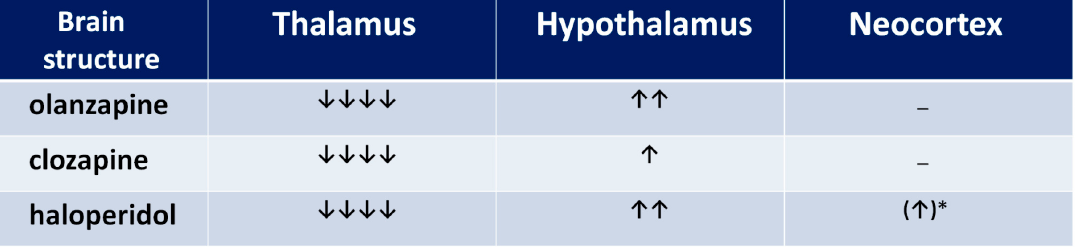
Figure 6. The influence of chronic neuroleptic administration on glutamatergic activity in thalamus, hypothalamus, and cortex in rats. A number of arrows indicate the neuroleptic’s potential to decrease or increase the glutamatergic activity, resulting from the summation of NR1 expression, and proportion of NR2A to NR2B expression (an arrow was added when NR2B expression prevailed, and subtracted when NR2A expression prevailed). * statistically